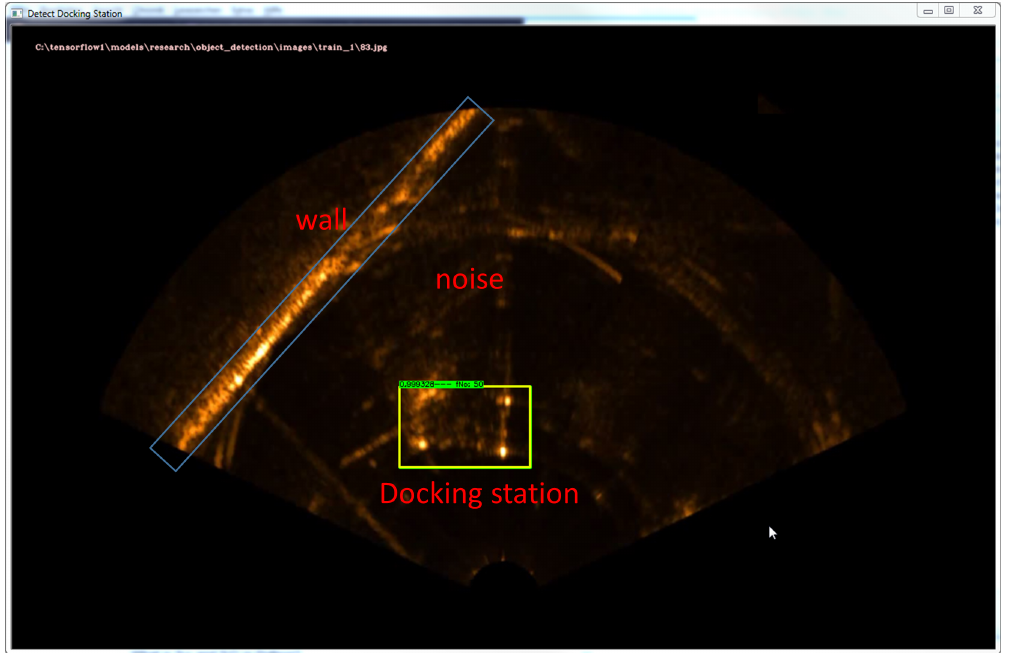
Figure 1. A typical acousitic image showing high background to object